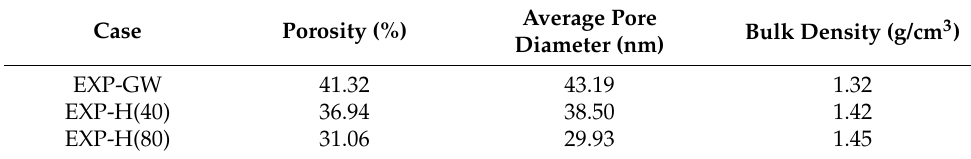
Average Pore Bulk Density (g/cm 3 ) Diameter (nm)